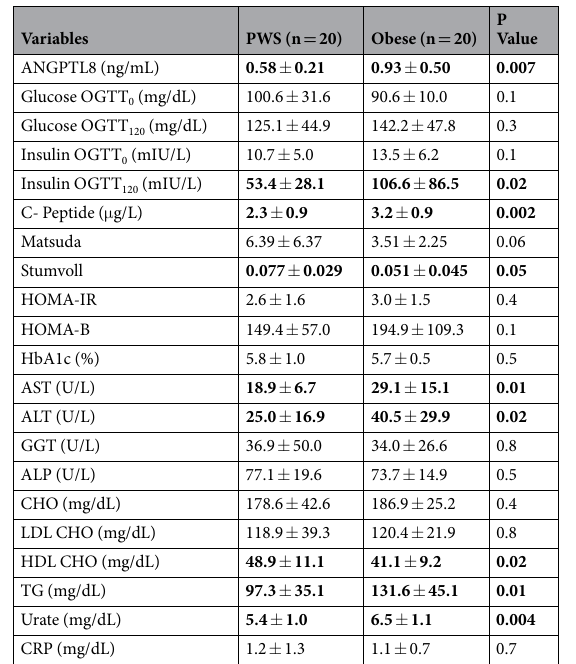
Table 2. Summary of biochemical data obtained in PWS subjects and obese controls. Data are expressed as mean ± SD. Comparison between populations was performed by ANOVA test. Significance is shown in bold characters. OGTT, Oral Glucose Tolerance Test; OGTT 0 and OGTT 120 , OGTT at time 0 min and 120 min; HOMA-IR, homeostatic model of insulin resistance; HOMA-B, homeostatic model of β cell function; HbA1c, glycated haemoglobin; AST, aspartate aminotransferase; ALT, alanine aminotransferase; GGT, gamma glutamyl transpeptidase; ALP, alkaline phosphatase; CHO, total cholesterol; LDL CHO, low density lipoprotein cholesterol; HDL CHO, high density lipoprotein cholesterol; TG, triglycerides; CRP, C-reactive protein.